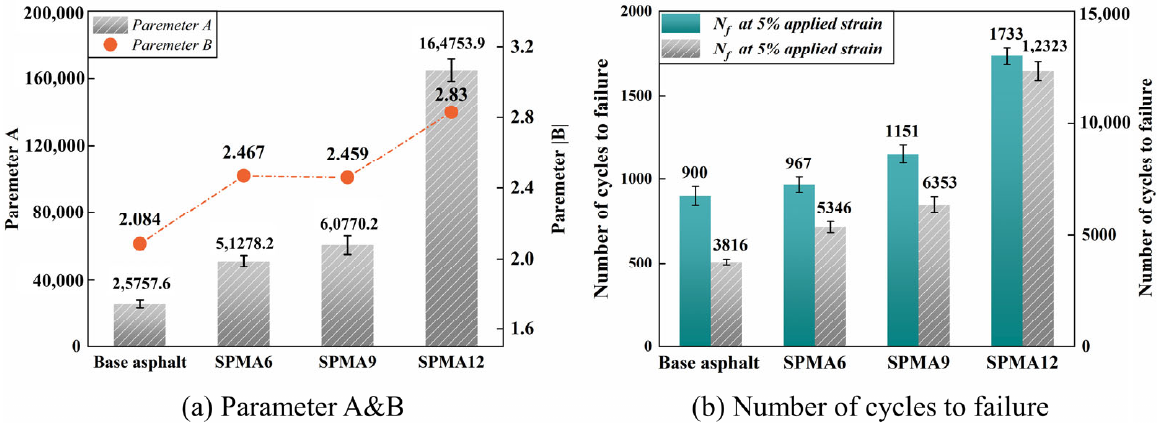
Figure 17. LAS test result of asphalt binders.